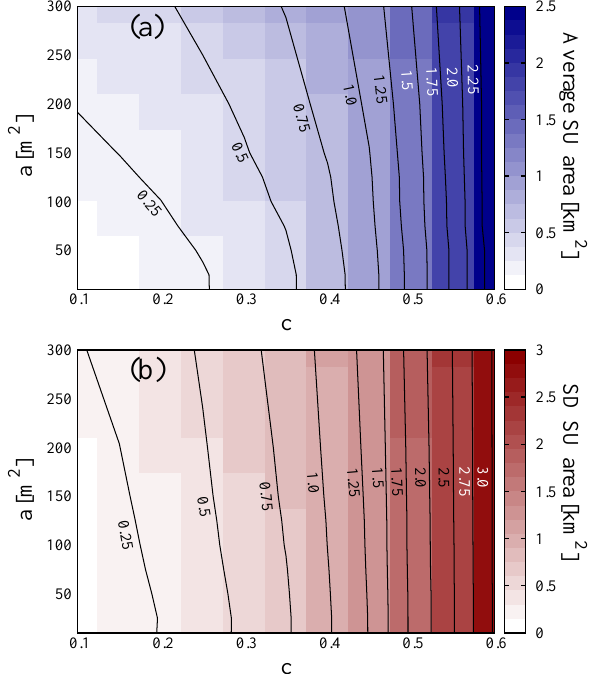
Figure 8. (a) Average and (b) standard deviation of the size of the SUs, for different combinations of a and c parameters. The mini- mum size of the SUs is fixed by the a parameter, and the maximum size of the SUs is independent of a .